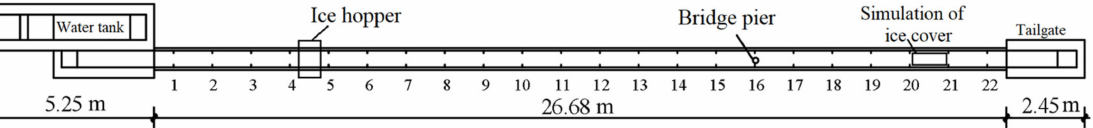
Figure 1. The setup of the experimental flume in the